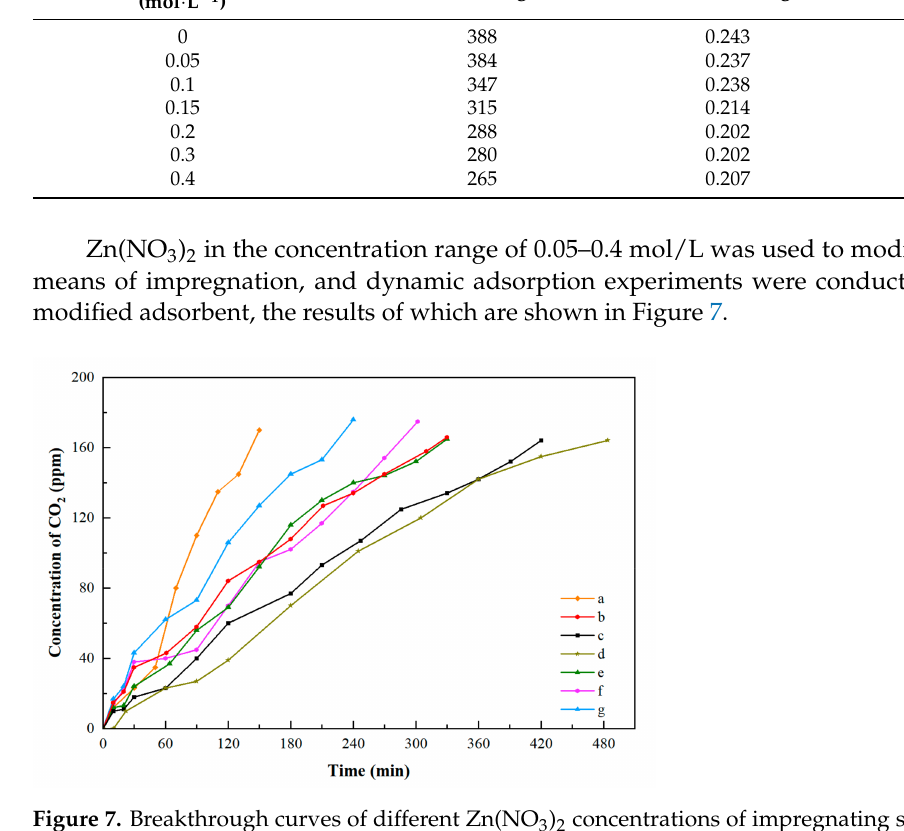
Figure 7. Breakthrough curves of different Zn(NO 3 ) 2 concentrations of impregnating solution are compared at 20 ◦ C: (a) blank, (b) 0.05 mol/L, (c) 0.1 mol/L, (d) 0.15 mol/L, (e) 0.2 mol/L, (f) 0.3 mol/L and (g) 0.4 mol/L,